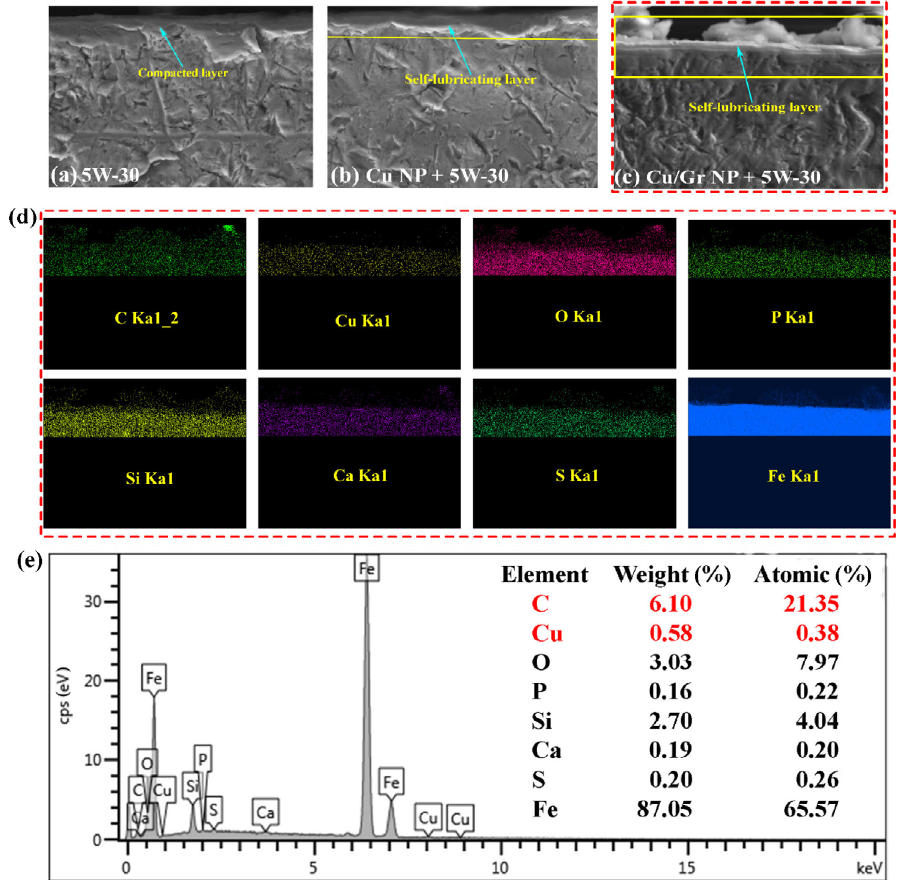
Fig. 9 Tribo-lubricating layers formed on the cross section of the ring lubricated by: (a) reference oil, (b) Cu nanolubricant, (c) Cu/Gr nanolubricant, and (d, e) EDS mapping and the spectrum of tribofilm elements, corresponding to the yellow dash line box in